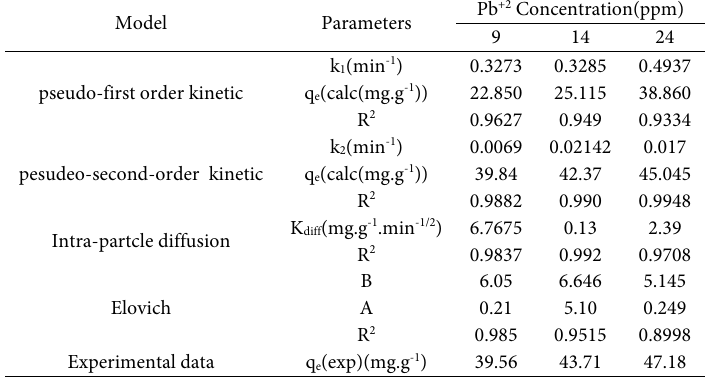
O @MCM-41-NH 3 4 2